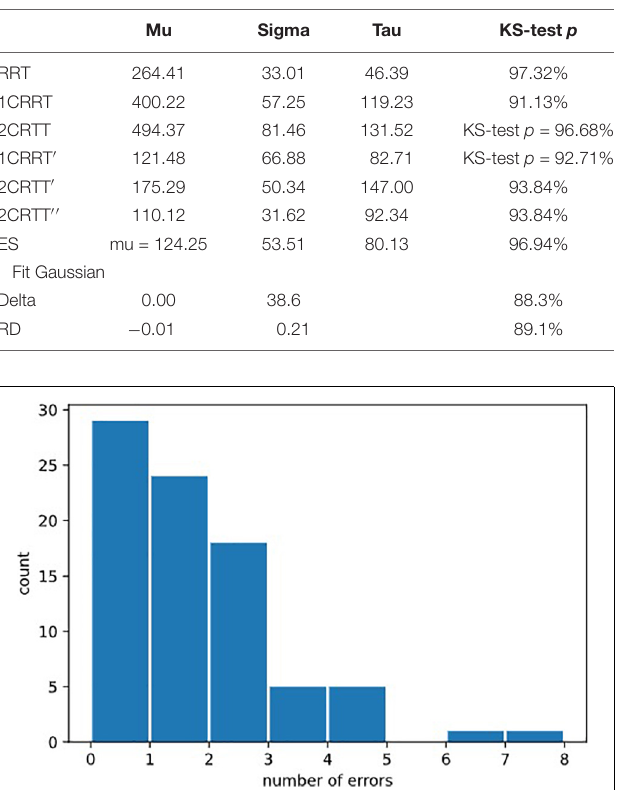
TABLE 3 | Ex-Gaussian fits of the distribution.